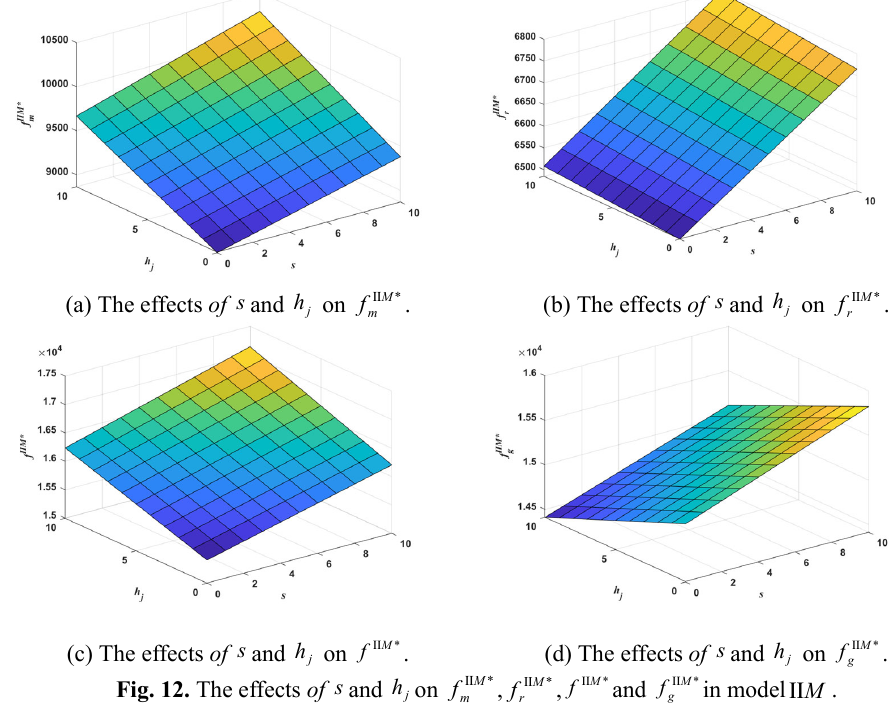
Fig. 12. The effects of s and